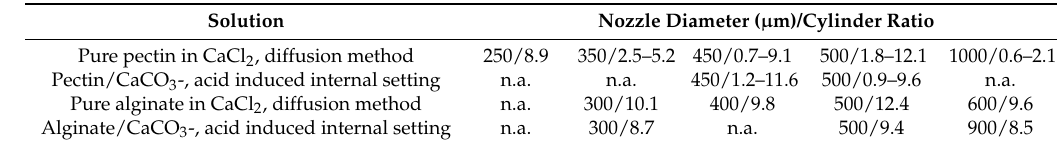
Table 2. Processed jet cutting experiments.